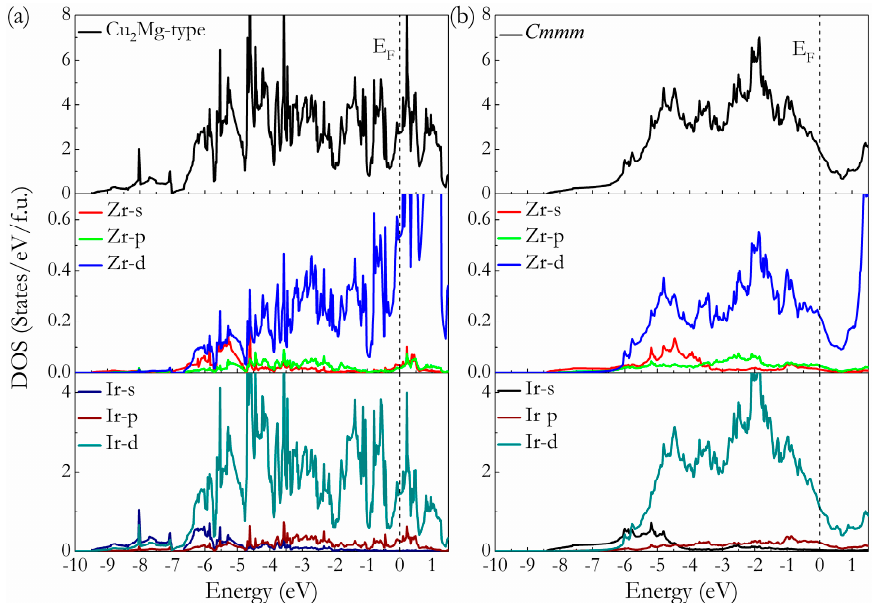
Figure 5. Calculated total and partial DOS of Cu 2 Mg-Ir 2 Zr ( a ) and Cmmm -Ir 2 Zr ( b ). The vertical dash line is the E F .